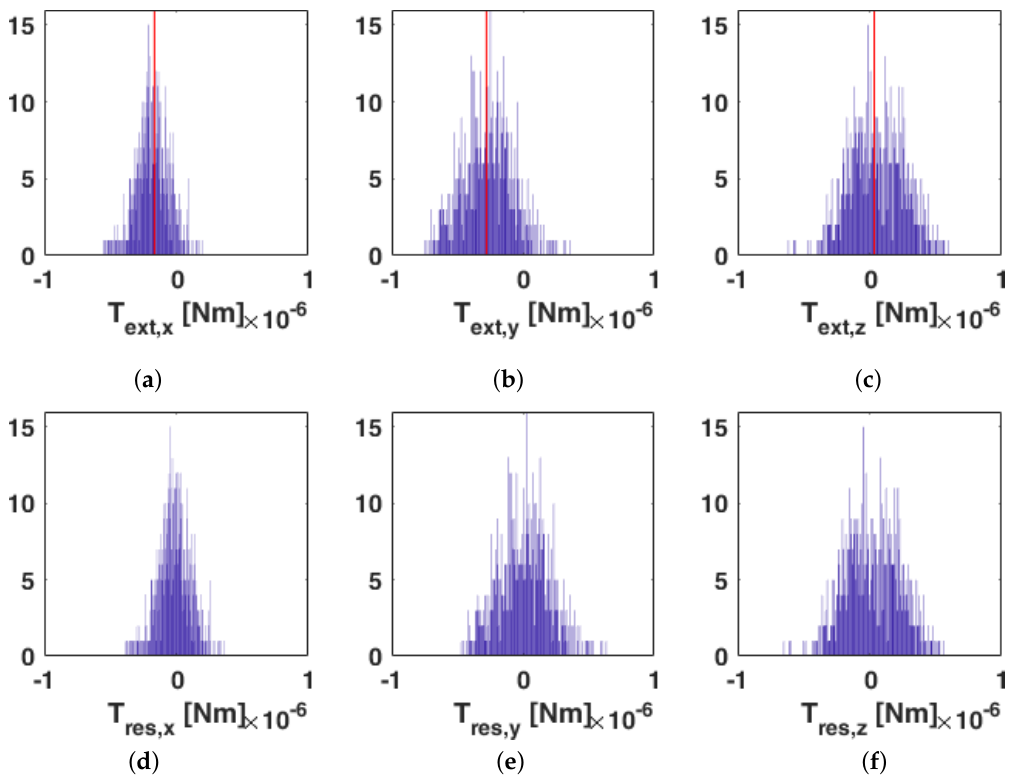
Figure 15. Histogram of the determined torques during thrust determination experiment on 31 May 2020. ( a – c ) The external torque (cid:126) T ext in the top row. The thruster torque (cid:126) T thr with the thrust determined using Equation (4) in red. ( d – f ) The residual torque (cid:126) T res = (cid:126) T ext − (cid:126) T thr in the bottom